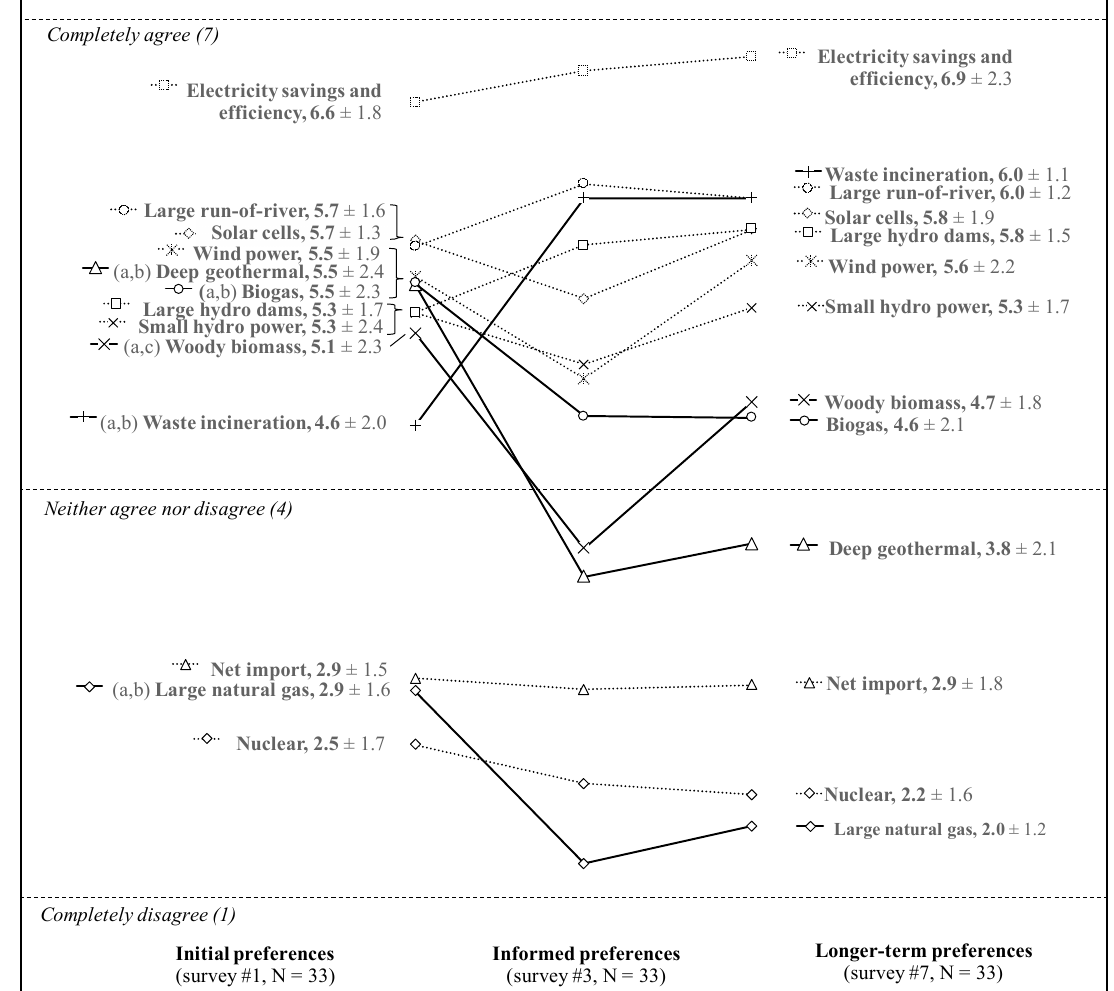
Figure 2. Average technology preferences of the informed citizen panel when asked to which extent they would agree to expanding individual electricity technologies in Switzerland in 2035 (seven-point Likert scale, 1 = Completely disagree to 7 = Completely agree). Statistically significant di ff erences ( p < 0.05) are: (a) between survey #1 and survey #3, (b) between survey #1 and survey #7), (c) between survey #3 and survey #7. Average informed preferences are: electricity savings and e ffi ciency = 6.8 ± 1.7, large run-of-river = 6.1 ± 1.0, solar cells = 5.4 ± 1.6, wind power = 4.9 ± 1.8, deep geothermal = 3.6 ± 2.2, biogas = 4.6 ± 1.7, small hydropower = 4.9 ± 1.9, large hydro dams = 5.7 ± 1.4, woody biomass = 3.8 ± 2.0, waste incineration = 5.6 ± 1.6, net import = 2.9 ± 1.5, large natural gas = 1.8 ± 1.0, and nuclear = 2.3 ±